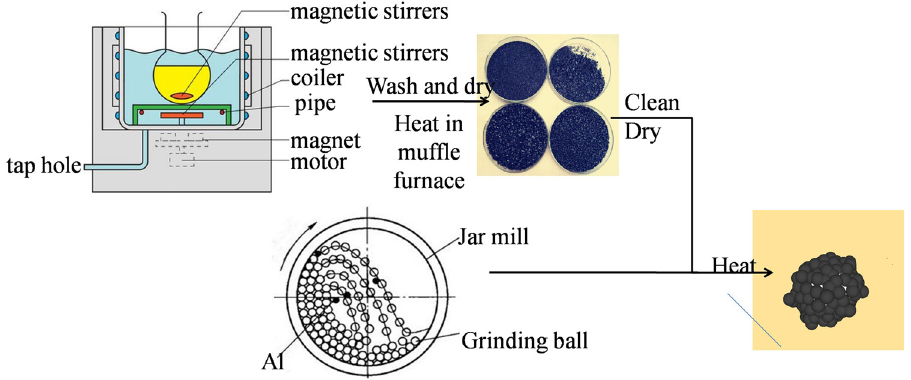
Figure 1: The preparation process of C@Al – EG